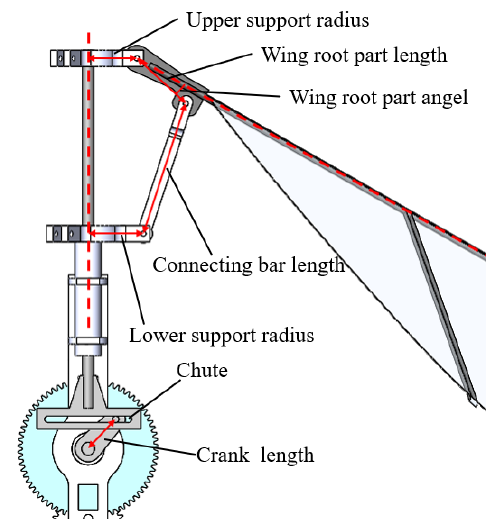
Figure 7. Flapping rotary mechanism.